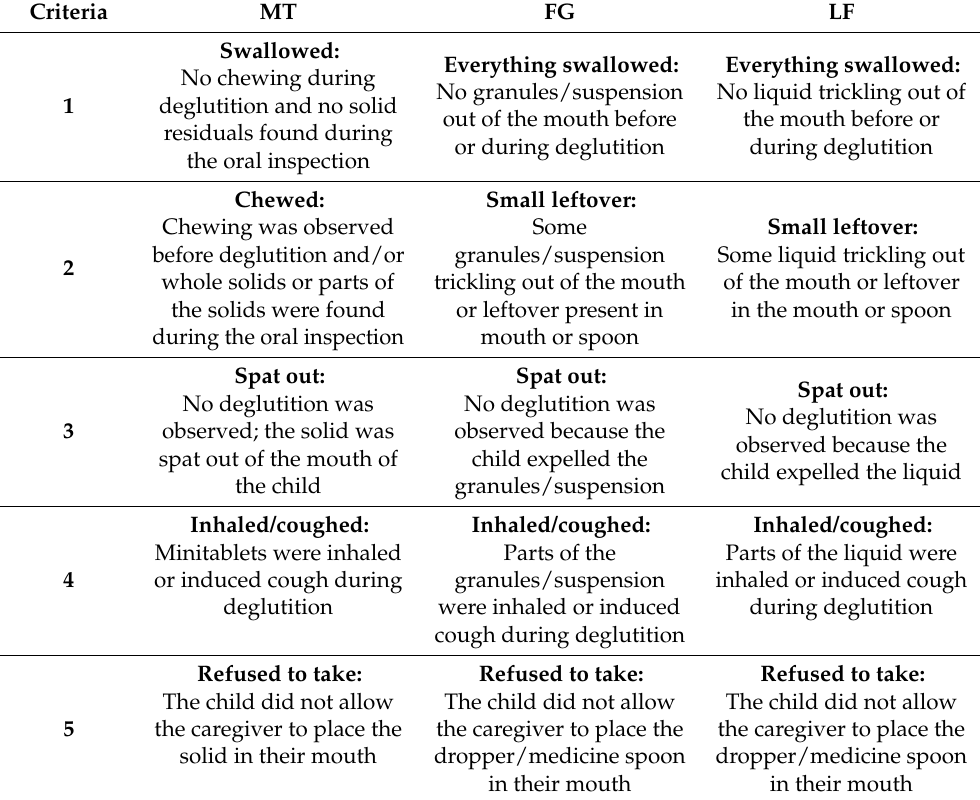
Table 2. The evaluation criteria used for the swallowability outcome of minitablets (MT), fine granules (FG), or liquid formulations